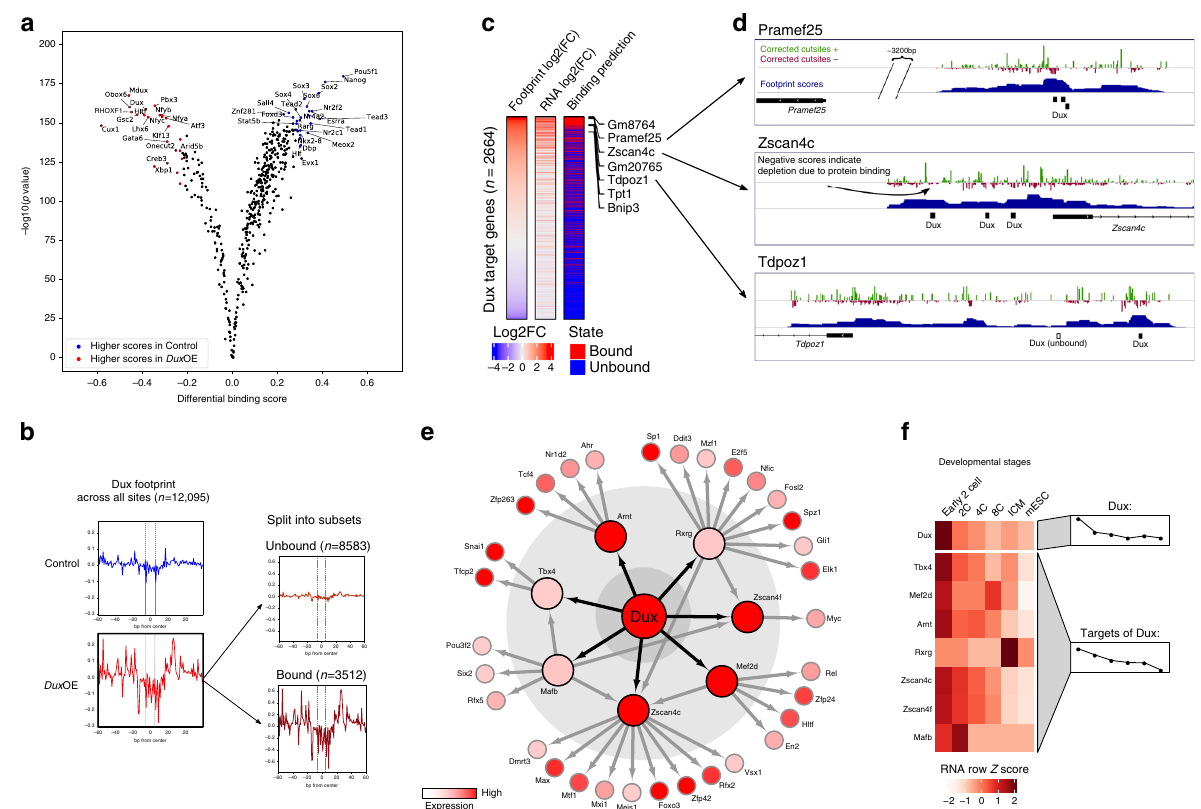
Fig. 4 Dux binding induces transcription at gene promoters. a Comparison of TF activities between mDux GFP- (Control; labeled in blue) and mDux GFP + ( Dux OE; labeled in red). Volcano plot showing the TOBIAS differential binding score on the x-axis and -log10 (p value) on the y-axis; each dot represents one TF. b Aggregated footprint plots for Dux. The aggregated plots are centered on the predicted binding sites for Dux between Control and Dux OE conditions (left: all genomic sites). The total possible binding sites for Dux OE ( n = 12,095) are separated into bound and unbound sites (right). The dashed lines represent the edges of the Dux motif. c Change in expression of genes near Dux binding sites. The heatmap shows n = 2664 Dux binding sites found in gene promoters. Footprint log2(FC) and RNA log2(FC) represent the matched changes between Control and Dux OE for footprints and gene expression, respectively. Log2(FC) is calculated as log2( Dux OE/Control). The column Binding prediction depicts whether the binding site was predicted by TOBIAS to be bound/unbound in the Dux OE condition. d Genomic tracks indicating three exemplary Dux binding sites and their target gene promoters and respective tracks for corrected cutsite signals (red/blue), TOBIAS footprint scores (blue), detected motifs (black boxes), and gene locations (solid black boxes with arrows indicating gene strand). e Dux transcription factor network. The TF-TF network is built of all TFBS with binding in TF promoters with increasing strength in Dux OE (log2(FC) > 0). Sizes of nodes represent the level of the network starting with Dux (Large: Dux, Medium: 1st level, Small: 2nd level). Nodes are colored based on corresponding RNA level in the Dux OE condition. Directed edges indicate binding sites in the respective gene promoter found by the TOBIAS CreateNetwork module. f Correlation of the Dux transcription factor network to expression during development. The heatmap depicts the in vivo gene expression during developmental stages. The right-hand group annotation highlights the difference in mean expression for each timepoint. The heatmap is split into Dux and target genes of Dux. Source data are available in the Source Data fi